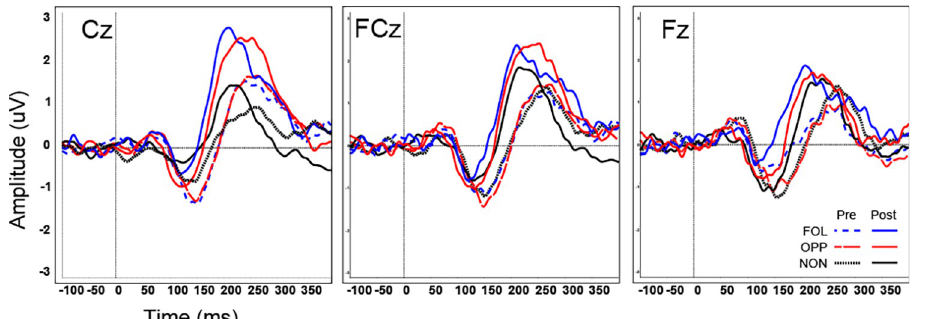
Fig 3. Grand-averaged ERPs by group at pretest and post-test. Grand averages of the ERPs at three electrode sites (Cz, FCz, and Fz) for all three groups: opposing (pre: red dashed line; post: red solid line), following (pre: blue dashed line; post: blue solid line), and non-varying (pre: black dotted line; post: black solid line).